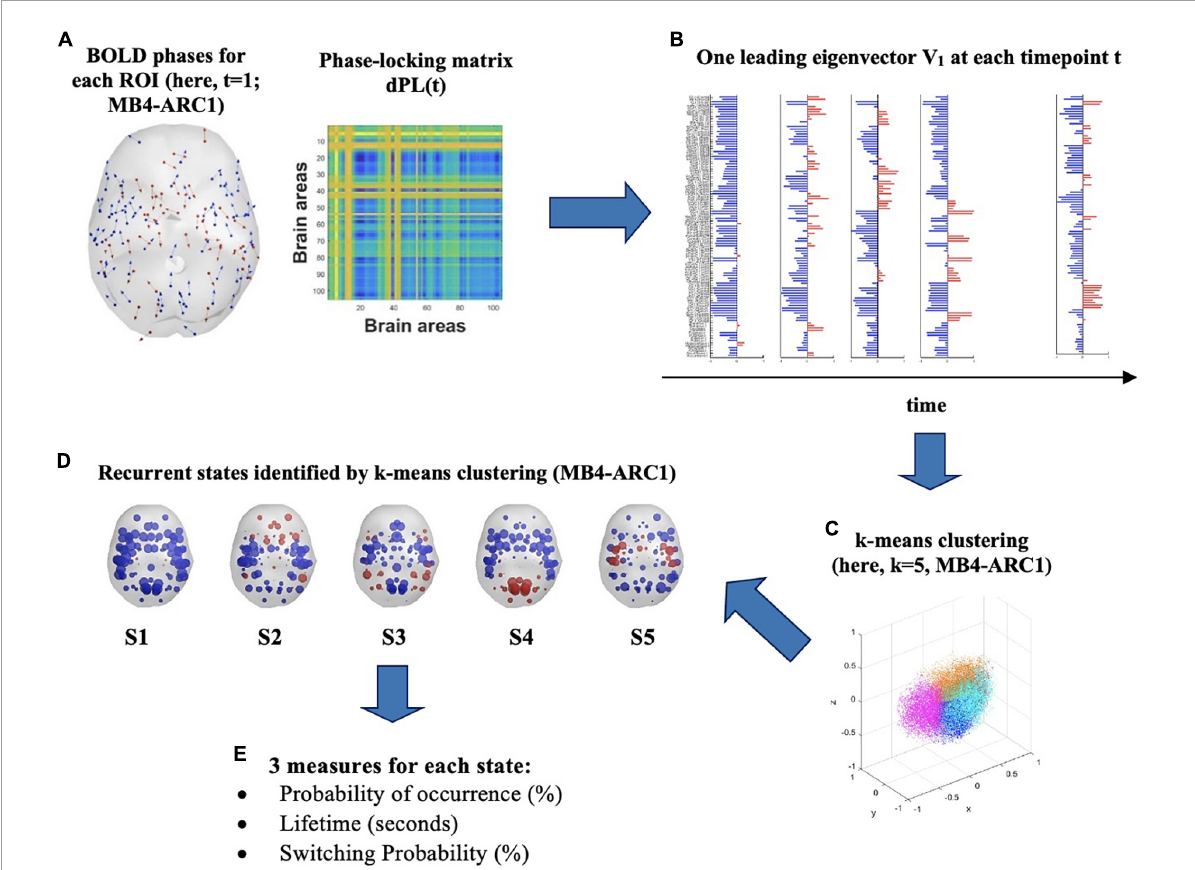
FIGURE1 Identification of recurrent BOLD phase-locking patterns (or states) in fMRI signals. (A) (left) Instantaneous BOLD phases represented in cortical space for each of the 105 ROIs. Each arrow represents the phase orientation of each ROI at timepoint t and is centered around the center of gravity of each ROI. Here, first volume ( t = 1) for MB4-ARC1. (right) The 105 × 105 dynamic phase-locking matrix dPL(t) captures the degree of synchrony between pairs of ROIs at time t. Red entries reflect full synchrony between pairs of ROIs (phase difference of 0 ◦◦ ) while blue entries indicate a phase difference of 180 ◦ . (B) At each timepoint t, the leading eigenvector V 1 (t) is a 105 × 1 vector which captures the dominant pattern of the dPL matrix, or main orientation of all BOLD phases, at time t. Each element in the bar plot represents the contribution of each ROI to V 1 (t) and is colored depending on its relative direction with respect to V 1 (t). Red means that the contribution is positive, while blue means it is negative. (C) K-means clustering divides the sample of all leading eigenvectors V(t) into a reduced number of k clusters, or states. Here, the Dunn score identified k = 5 as the optimal number of states to best explain the MB4-ARC1 data. (D) Each sphere represents the center of gravity of a ROI, and each color represents the direction of the projection of the ROI’s phase onto the leading eigenvector V 1 of that state. Here, k = 5 for MB4-ARC1. (E) Three measures are then extracted for each of these states: the probability of occurrence of each state, its lifetime and the probability of switching from one state to